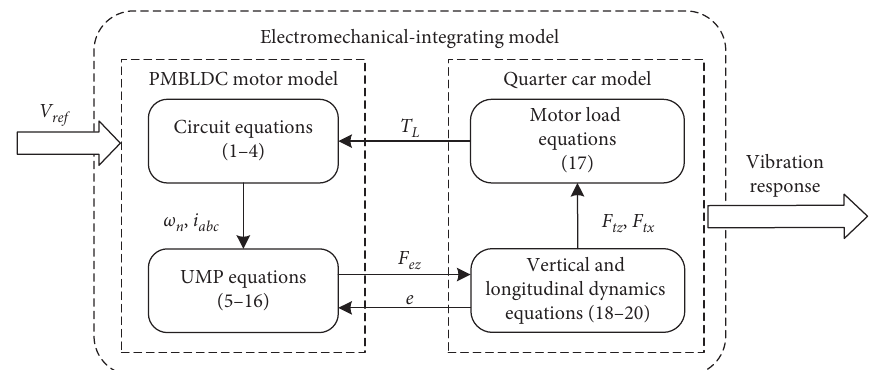
Figure 6: Electromechanical-integrating model logical diagram.